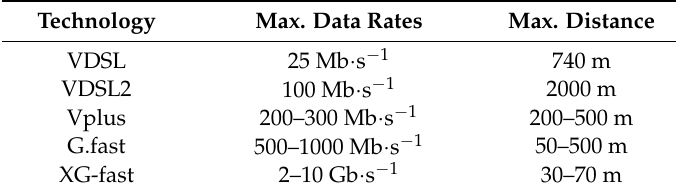
Table 4. Characteristics of data transmission